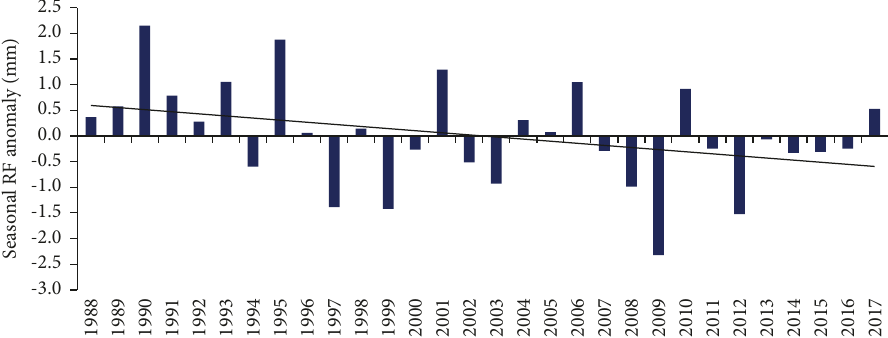
Figure 5: Belg rainfall anomaly (FMAM) at study area in the period of 1988–2017. Table 4: Annual and seasonal maximum temperature trends at Welmera district (1988–2017).